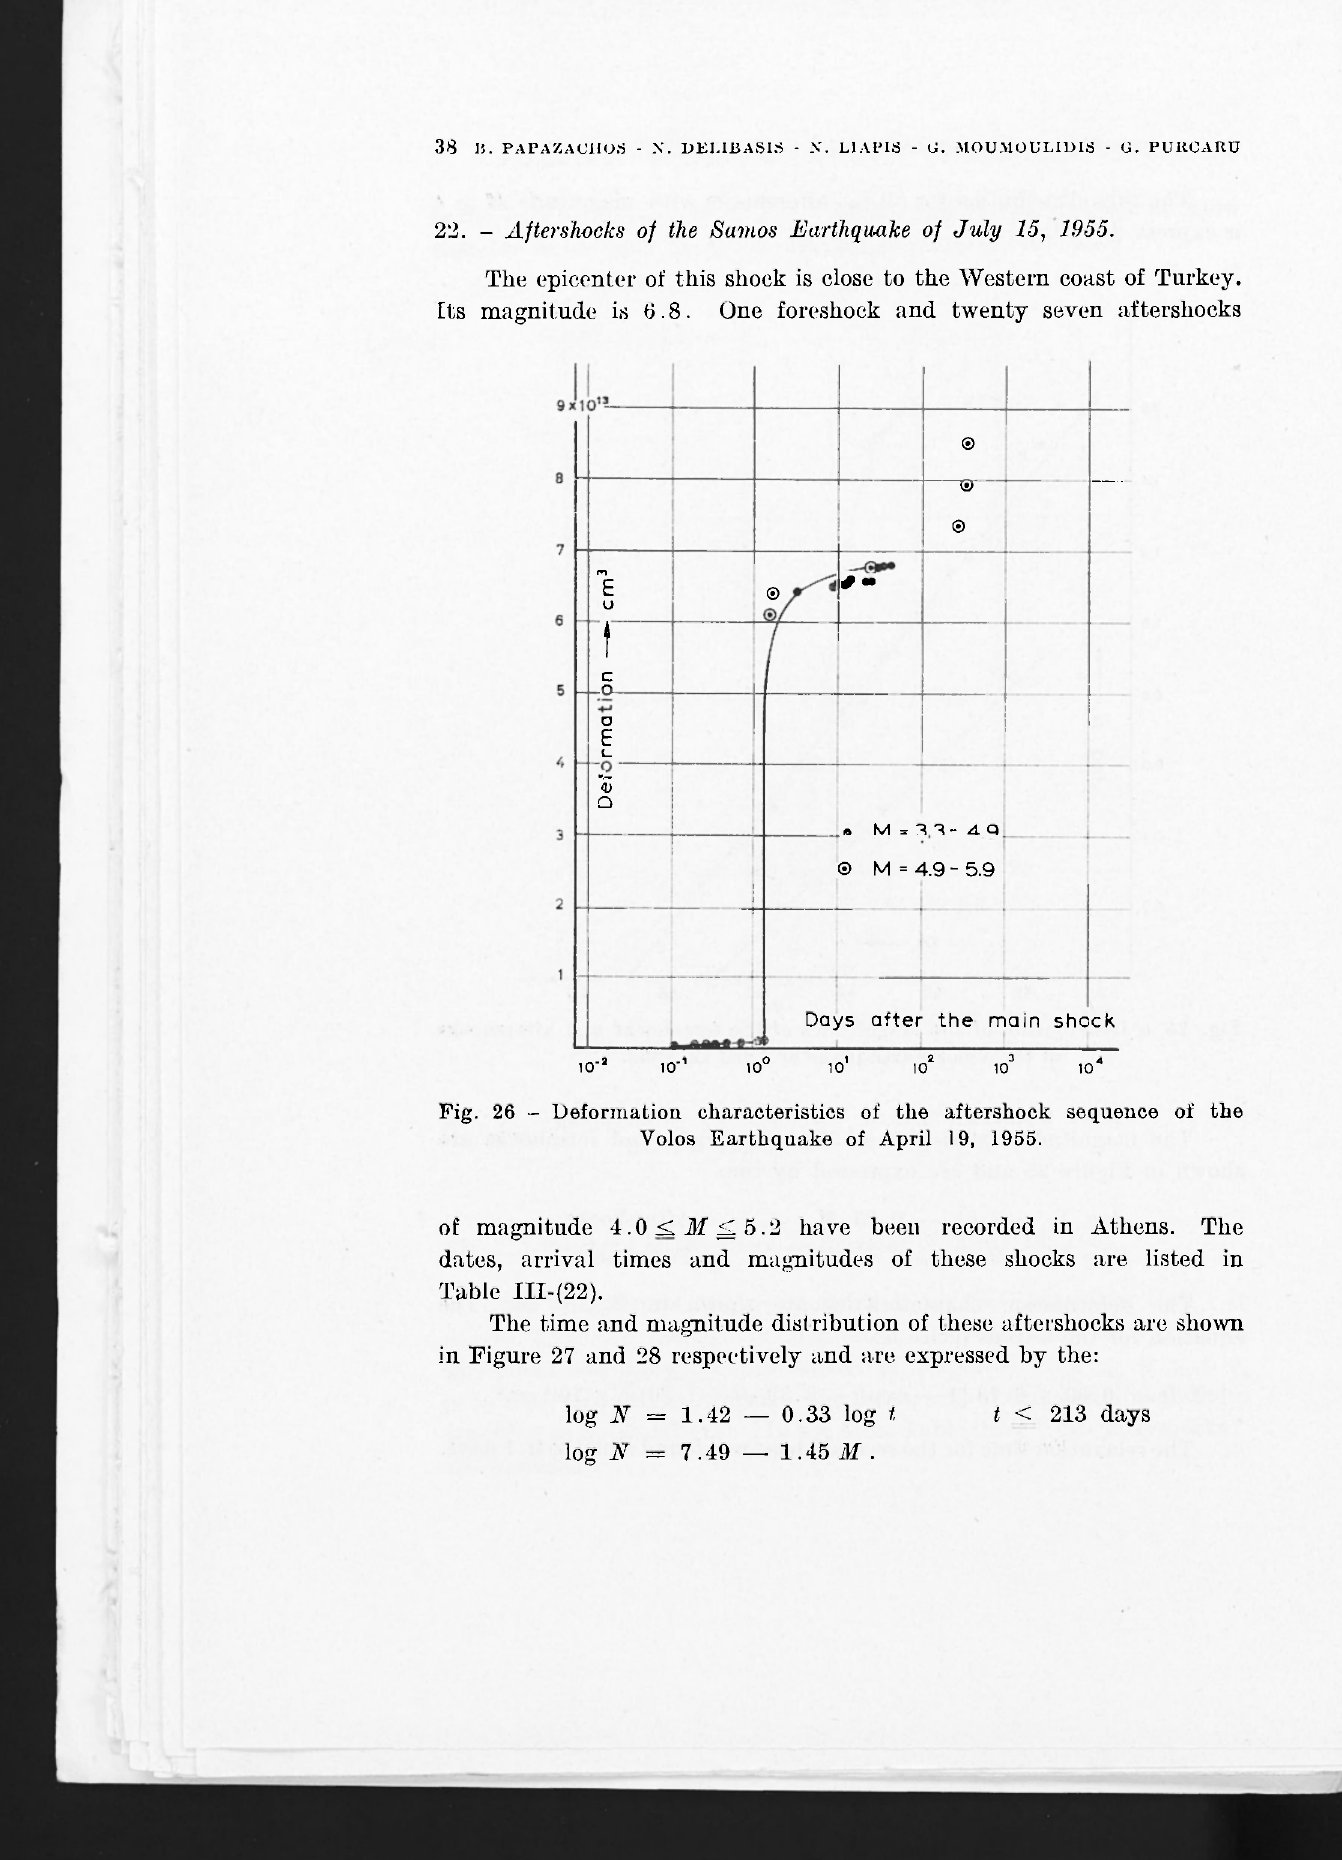
Fig. 26 - Deformation characteristics of the aftershock sequence of the Volos Earthquake of April 19,